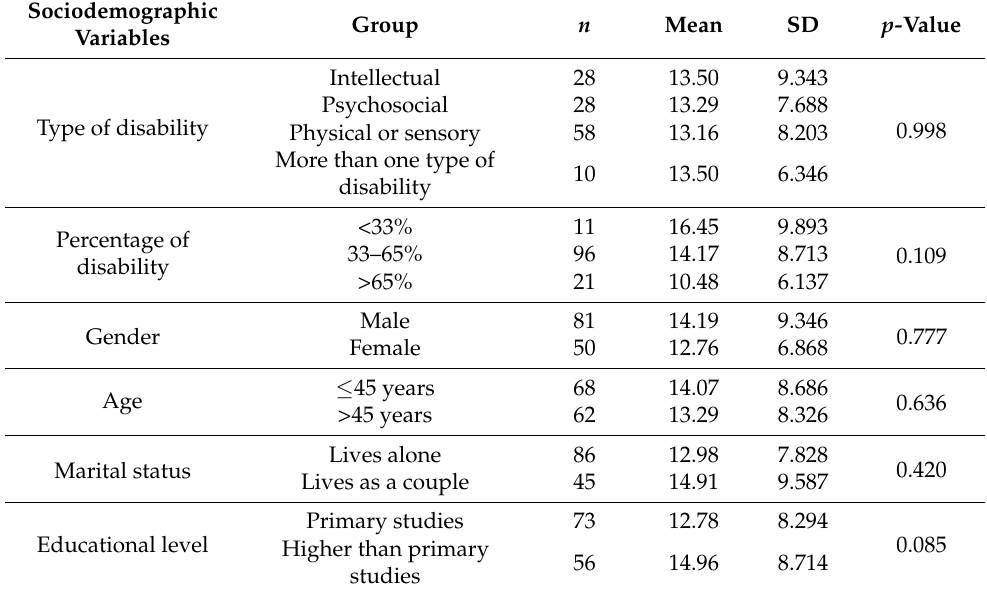
Table 2. Differences between groups in the primary outcome variable “emotional exhaustion” using ANOVA and Mann–Whitney U